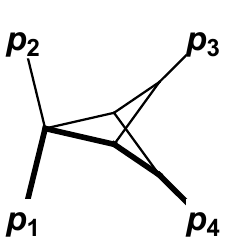
Figure 6. Non-planar two-loop three-point topology.